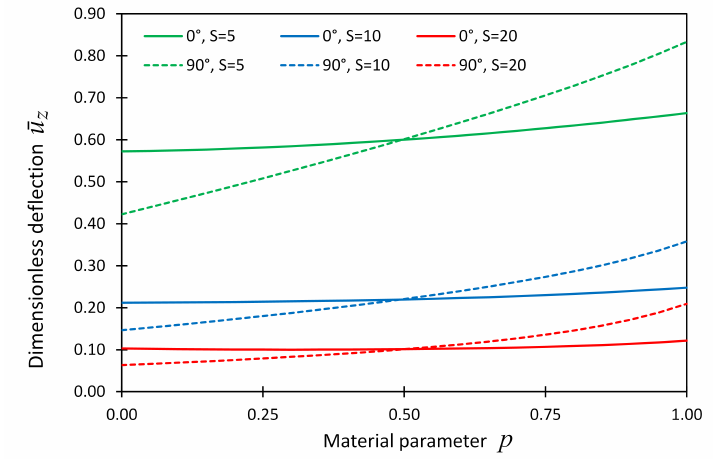
Figure 7. The dimensionless displacement, ¯ u z , at locations ( x , y , z ) = ( L x /2, L y /2, L z /2) versus material parameter p for Example 2 considering boundary conditions SSSS; the reference solution given in (Ravindran 2019) [19] is shown by solid dots.